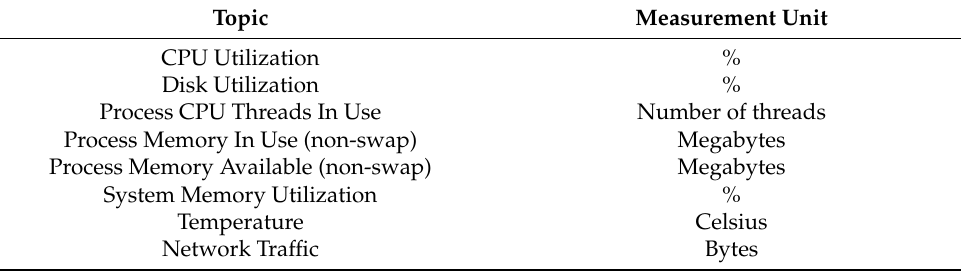
Table 4. Topics of client device system information.